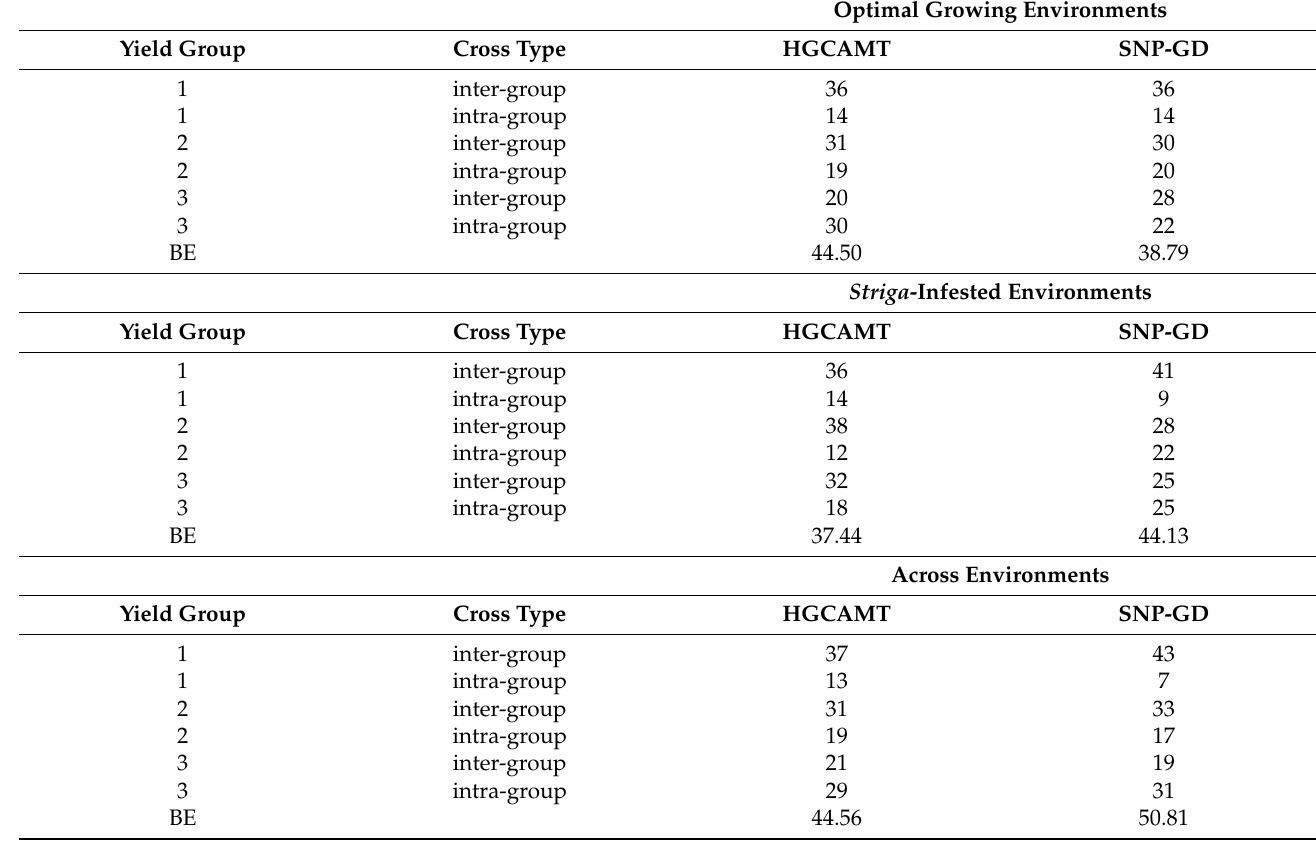
Table 6. Numbers of inter- and intra-group hybrids categorized by the HGCAMT and SNP genetic distance (GD)-based heterotic grouping methods and the breeding efficiency (BE) of the different methods under optimal, Striga -infested, and across